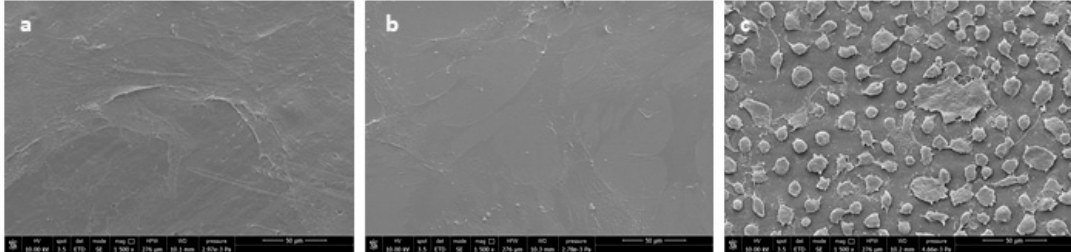
Figure 11. SEM micrographs of films cultured in contact with hMSCs: ( a ) F3, ( b ) PLA, ( c ) LDPE.